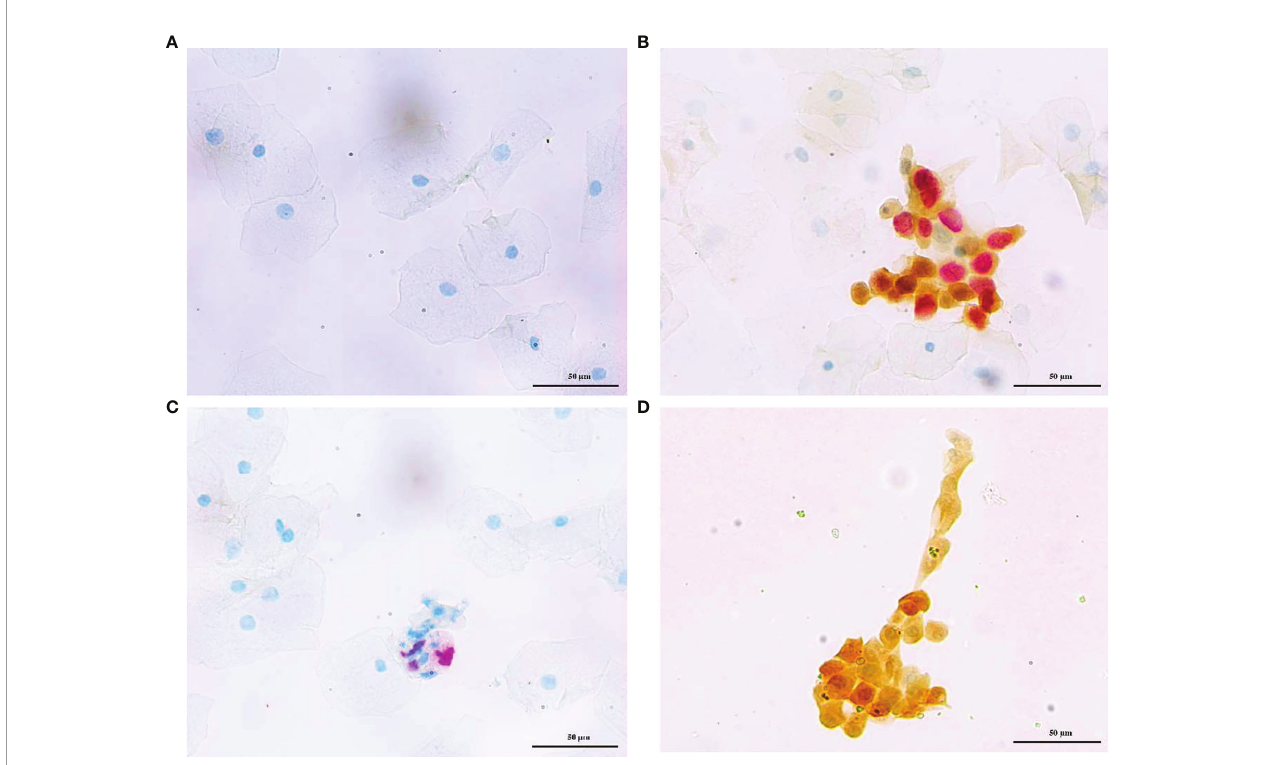
FIGURE 2 | Representative photos of p16/Ki-67 dual stain cytology. Cervical exfoliated cells negative (A) and positive (B) for for Dalton, negative (C) , and positive (D) for CINtec ® PLUS, respectively. The brown cytoplasm/nuclear signal showed p16 staining alone, and the red nuclear signal showed Ki-67 staining alone. The positive p16/Ki-67 dual stain cell had both brown and red signal, which re fl ected the colocalization of p16 and Ki-67 in the same